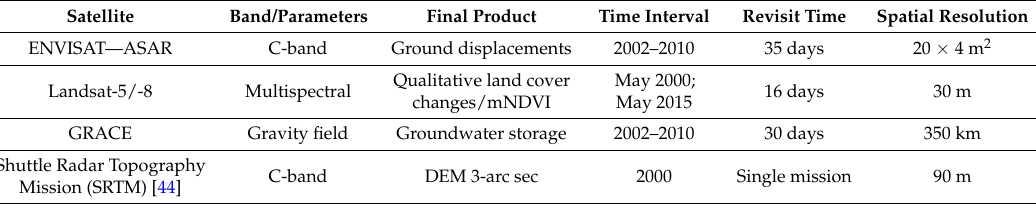
Table 1. Satellite-based data.